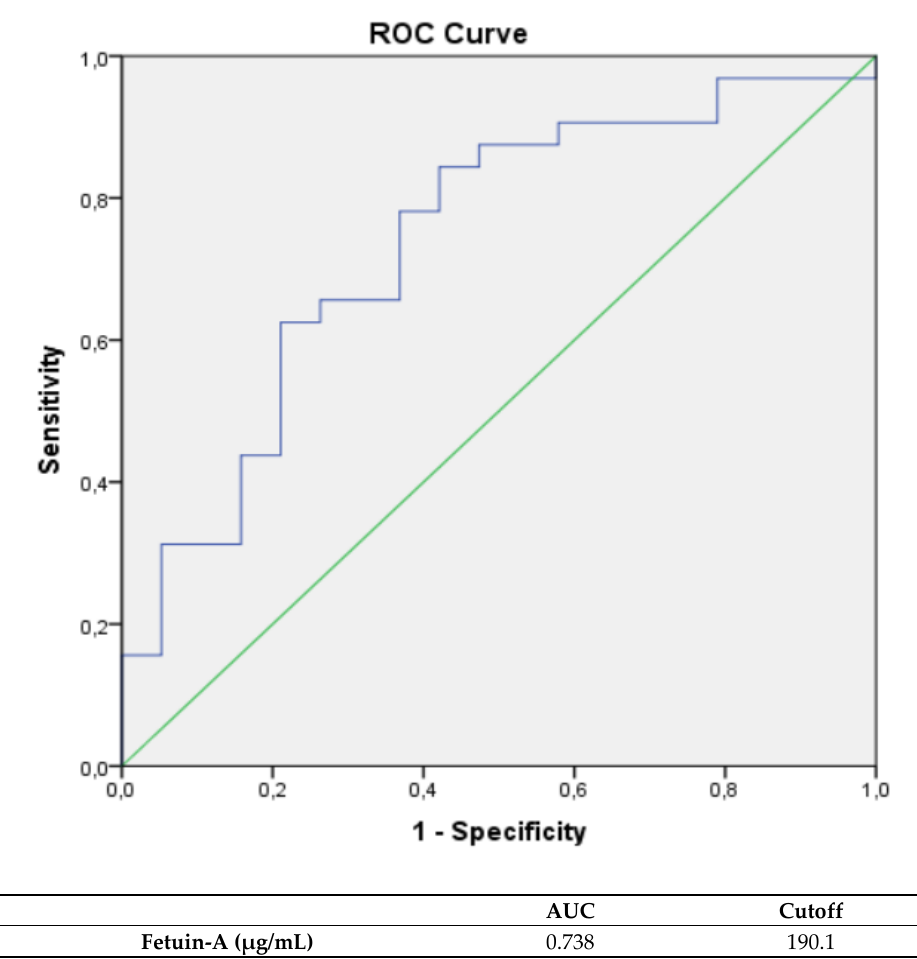
Figure 1. ROC curves and cutoff scores for fetuin-A for the prediction of a clinical course with cardiac decompensation in the total cohort.